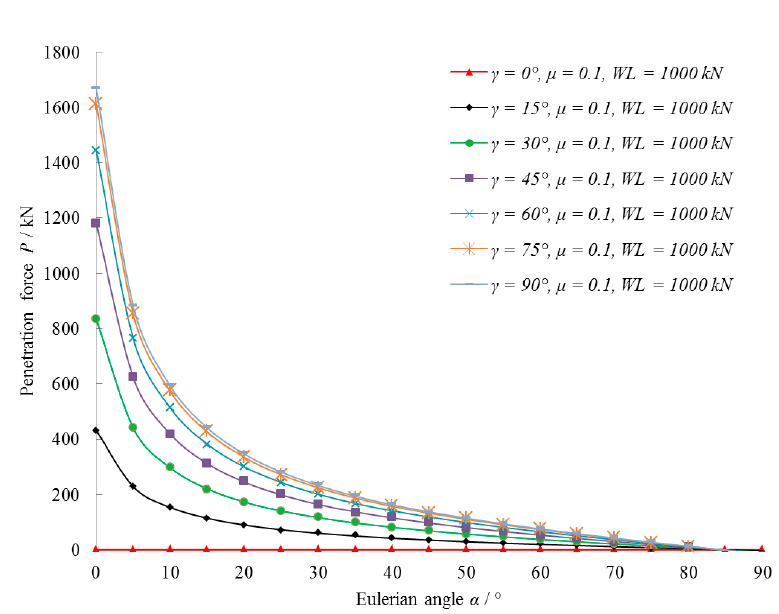
Figure 14. Relationship between the penetration force P and Eulerian angle α .